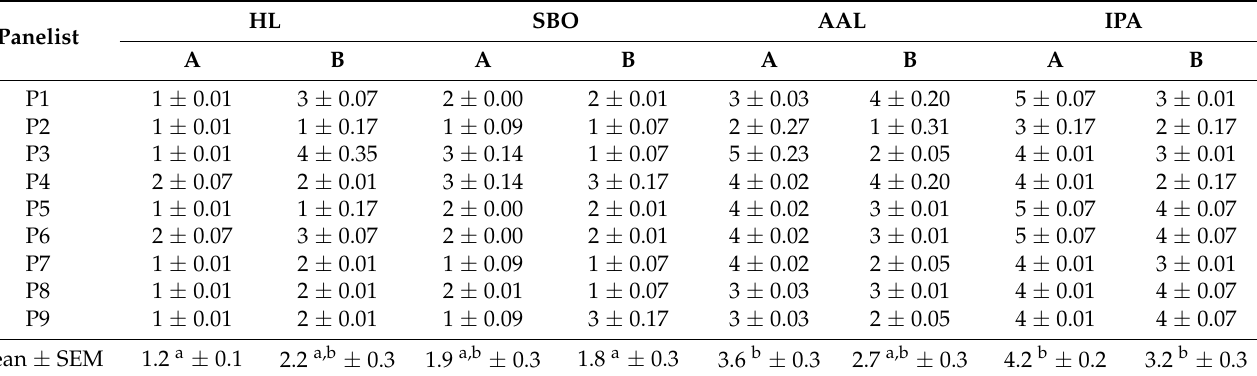
The numerical data represent the panelists’ classification according to their taste perception from low to high (1 to 5) astringency and bitterness. Values within the table are the score attributed to astringency and bitterness ± variance. Values in the last line are means of the panelists scores ± standard error of the mean (SEM). Values with different superscripts (a and b) are statistically different at p < 0.001. The analysis was performed comparing the different beers in the same sensory attribute (e.g., astringency in HL compared to the astringency in the remaining beers). The panelists (cid:48) SP behavior after consuming beers was primarily divided into two different behaviors: SP content reduction in the basal level (e.g., panelist 1, 5, 7, and 8) or SP production due to saliva stimulation (e.g., panelist 2, 3, 4, 6, and 9). Interestingly, it was also observed that panelists with higher basal SP content (panelists 5, 7, and 8) showed a higher reduction pattern presented by a fold of 2 to 4x (e.g., panelist 5). In general, the